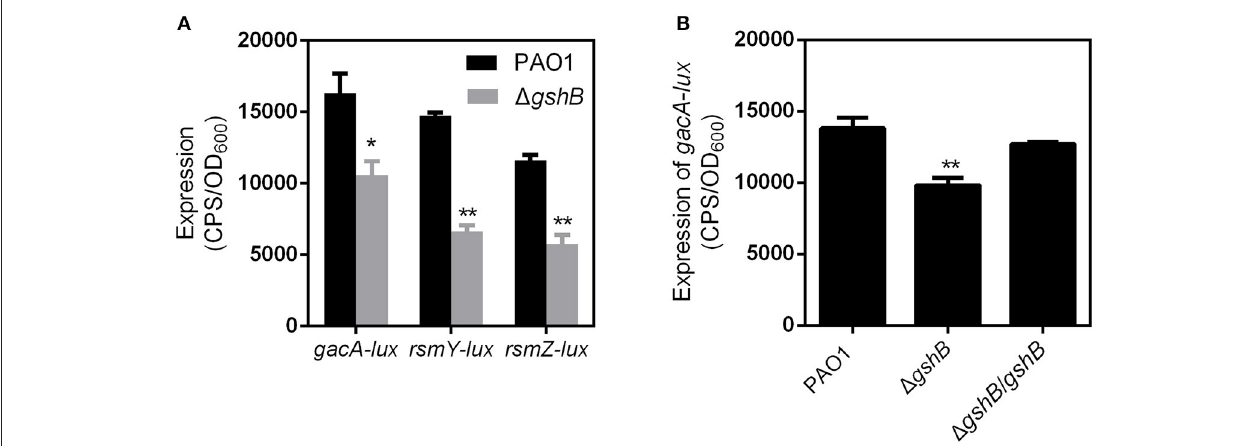
FIGURE 4 | The expression of vfr, gacA, rsmY, and rsmZ genes in the indicated P. aeruginosa strains. (A) The expression of gacA, rsmY, and rsmZ genes in the PAO1 and 1 gshB strains. (B) The expression of gacA in the 1 gshB genetically-complemented strains. * P < 0.05, ** P < 0.01 compared to PAO1 by Student’s t